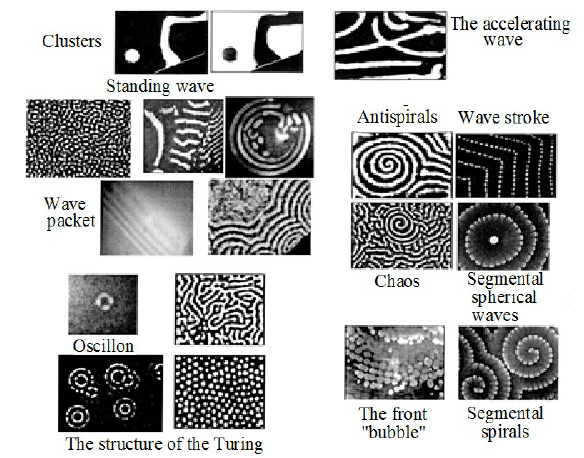
Fig. 2. Bouquet of autowaves of various types, including spiral autowaves, obtained and studied by V. K. Vanag